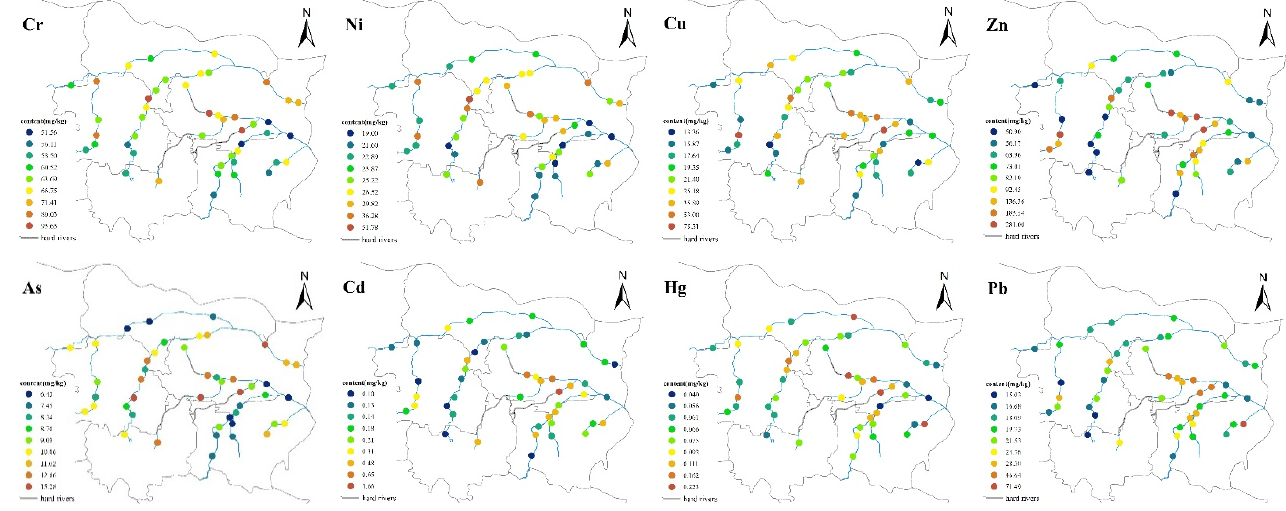
Figure 5. Spatial distribution of PTE concentration in river surface sediments of Zhengzhou.